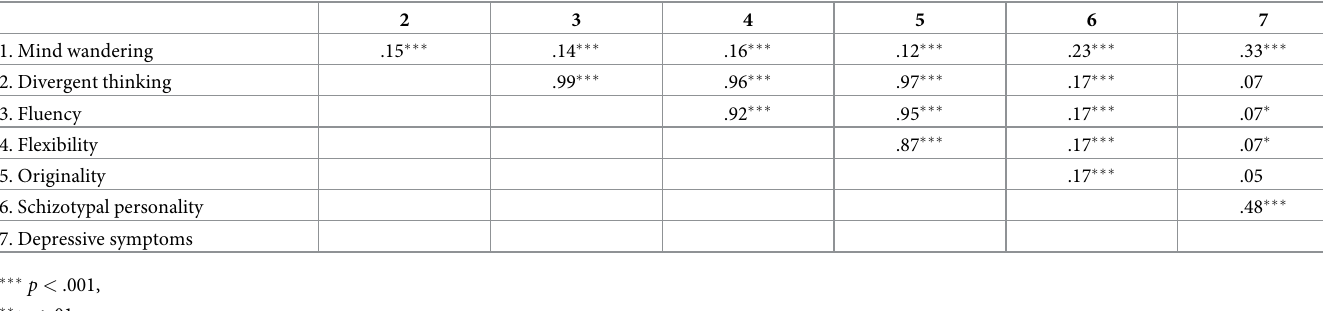
Table 2. Correlations between variables of mind wandering, divergent thinking, and mental health.